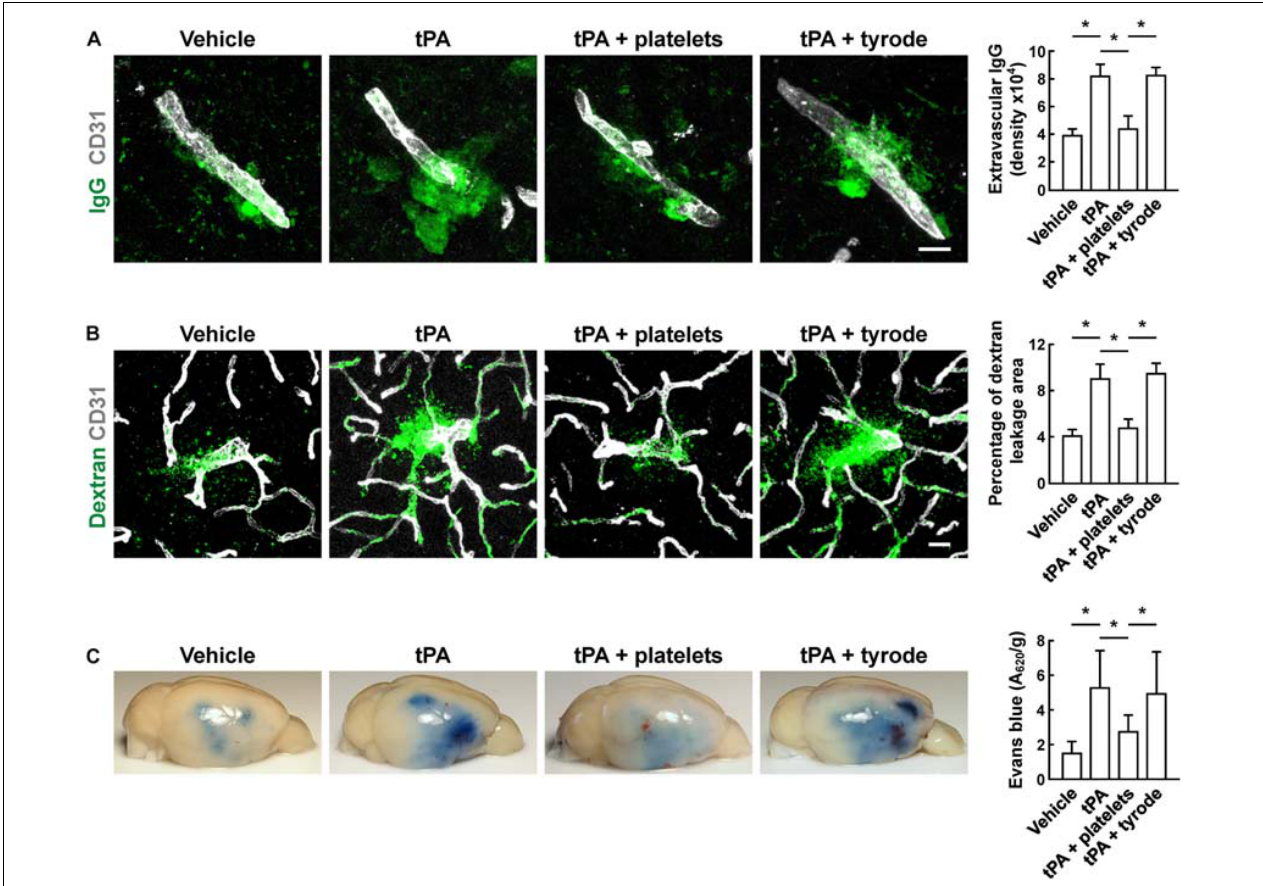
FIGURE 2 | Transfusion of resting platelets reduced tPA-induced BBB disruption after cerebral ischemia. (A) Representative images and quantitative analysis of IgG leakage 24 h after cerebral ischemia in mice treated with vehicle, tPA, tPA + resting platelets, or tPA + tyrode buffer. Bar = 10 µ m. n = 5 per group. (B) Representative images and quantitative analysis of extravascular dextran fluorescence in mice treated with vehicle, tPA, tPA + resting platelets, or tPA + tyrode buffer. Bar = 20 µ m. At 24 h after stroke, mice were given an intravascular injection of 40,000 Da FITC-labeled dextran, and brain sections were stained with CD31. n = 5 per group. (C) Representative photographs and quantification of Evans blue dye extravasation 24 h after cerebral ischemia. n = 8 per group. Values are mean ± SD. ∗ P <